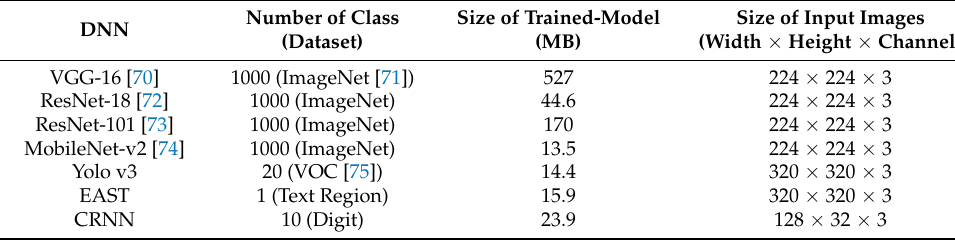
Table 5. List of DNNs used in performance evaluation.